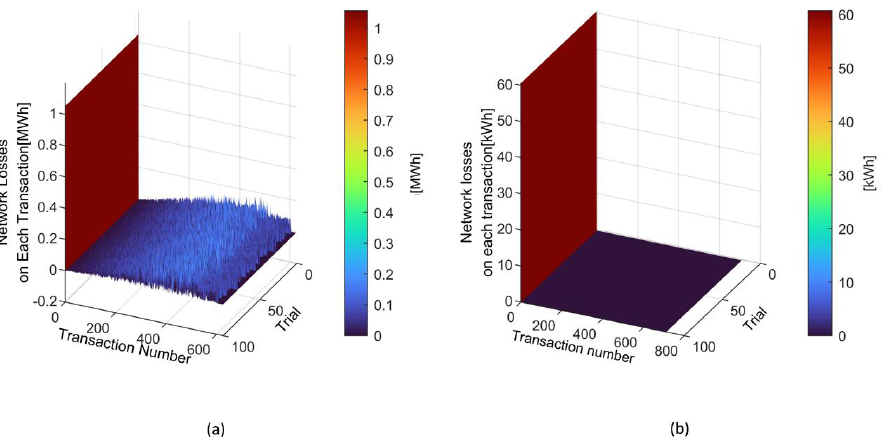
Figure 11. Network Loss depending on the transaction number for the 100 trials of the guided case simulations: ( a ) the IEEE 39 bus case with the transaction limit 50 MWh; ( b ) the IEEE 33 bus case with the transaction limit 5 kWh.